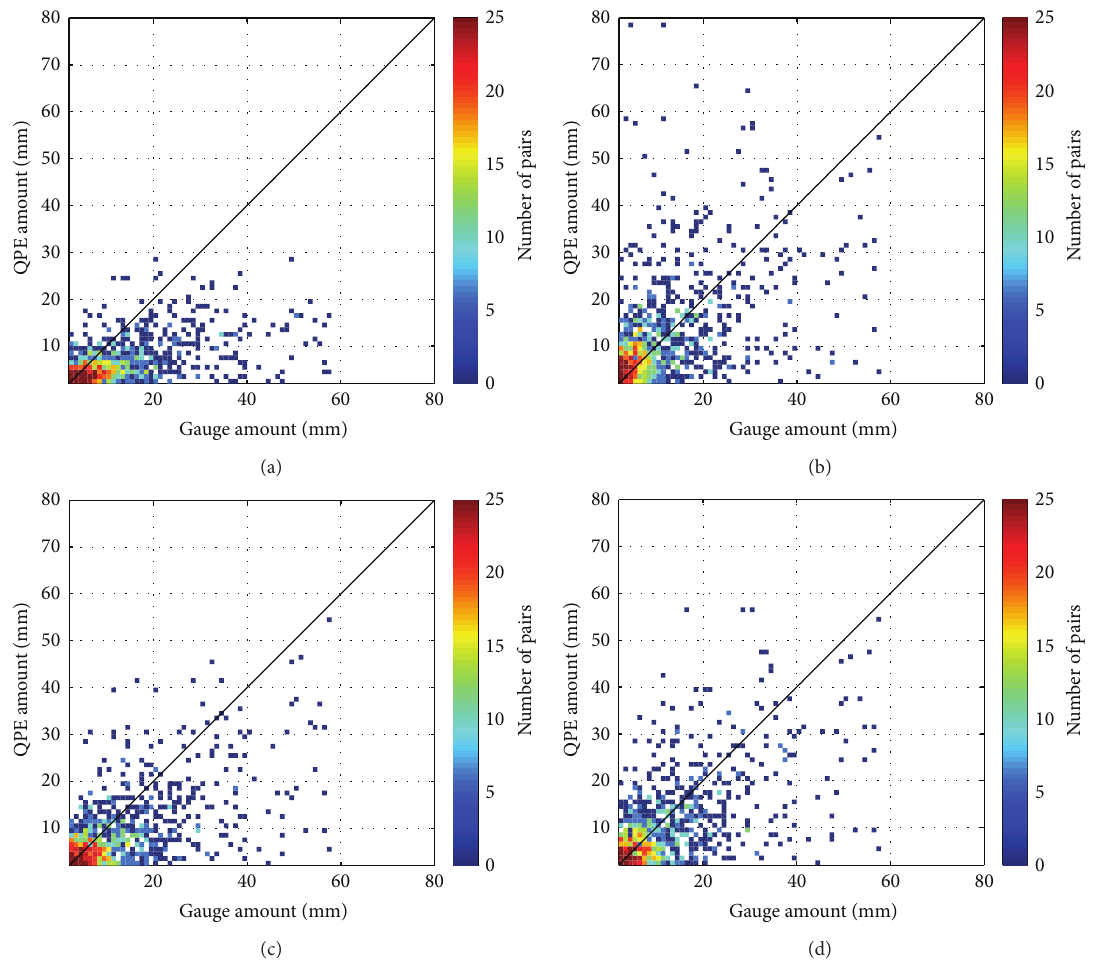
Figure 13: Similar to Figure 12, only those QPE-gauge pairs in which gauge’s heights are 500 m or higher above sea level are selected. There are a total of 1665 QPE-gauge pairs used in this